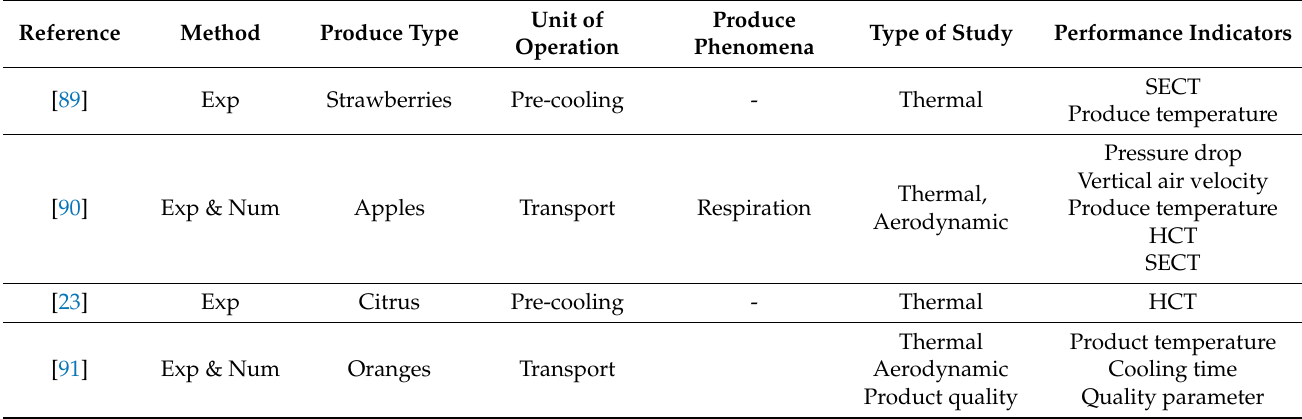
Table 3. Studies focusing on the cooling inside a pallet at the refrigerating facility